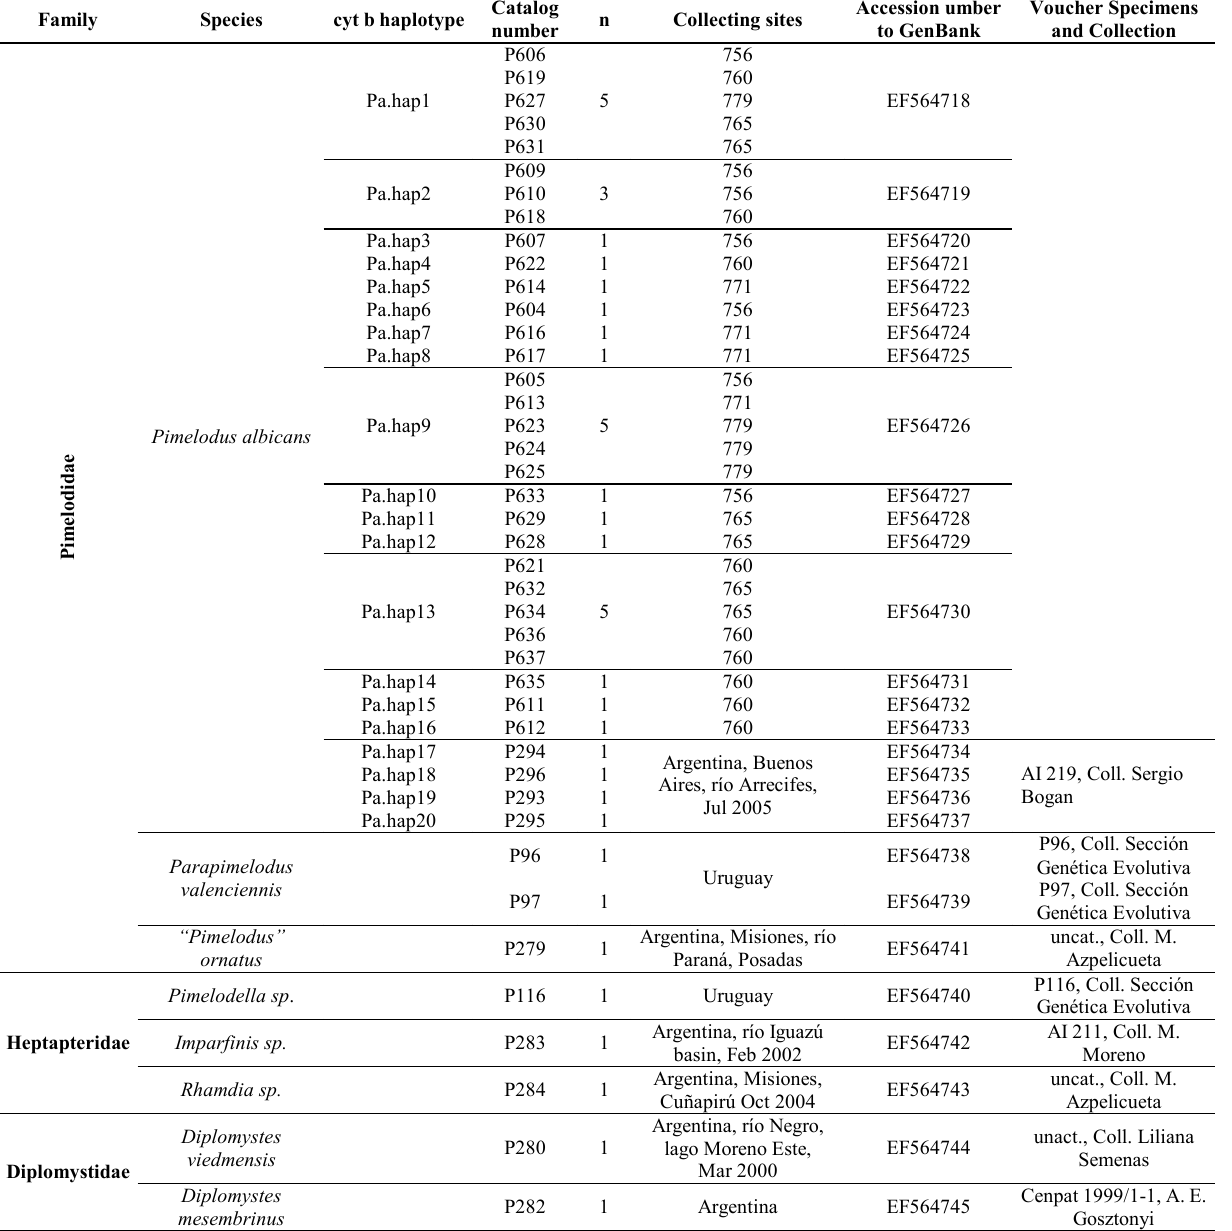
Table 1. Specimens list included in this study. The corresponding number of laboratory catalog identification for each sample and cyt b haplotype in P. albicans are indicated. The number of specimens corresponding to each haplotype, their collecting sites GenBank Accession Numbers and Number of Voucher Specimens and Collection are